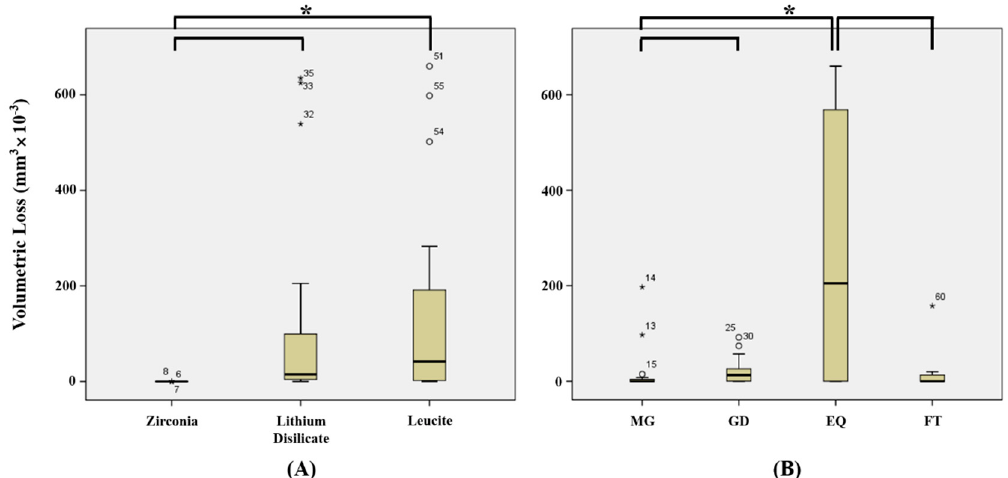
Figure 4. Volumetric losses of ceramic specimens ( mm 3 × 10 − 3 ). ( A ) Mean volumetric loss of ceramic regardless of composite resin type. ( B ) Mean volumetric loss of ceramic according to composite resin type. MG, MI Gracefil; GD, Gradia Direct P; EQ, Estelite Σ Quick; FT, Filtek Supreme Ultra. * Statistical significance.